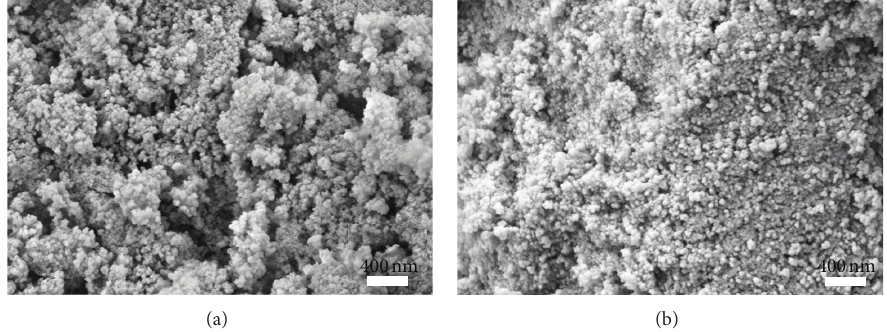
Figure 2: SEM images of as-prepared samples: (a) BSO sample and (b) 1%-Pr-BSO sample.